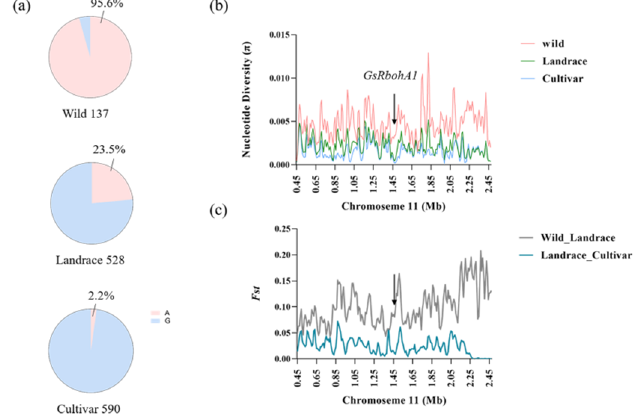
Figure 7. The resistance haplotype of GsRbohA1 was gradually lost during soybean domestication. ( a ) Proportion of GsRbohA1 A and GsRbohA1 G in wild, landrace and cultivated soybeans. ( b ) Nucleo- tide diversity (π) analysis of the 2 Mb region flanking GsRbohA1 . ( c ) Level of genetic differentiation ( F st ) across 2 Mb regions flanking GsRbohA1 between subspecies.